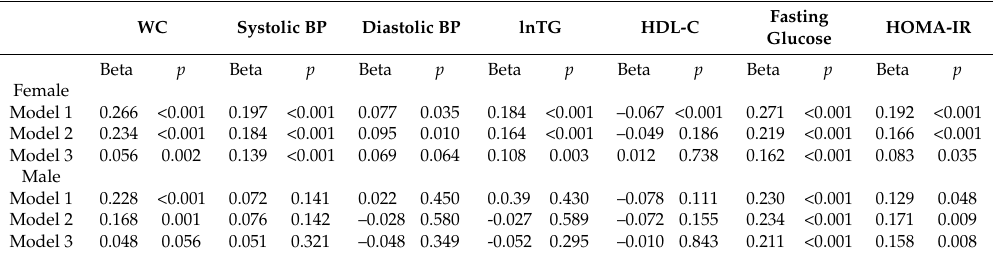
Table 5. Linear regression models showing standardized betas with serum selenium concentrations as independent variable for metabolic factors, stratified by gender.